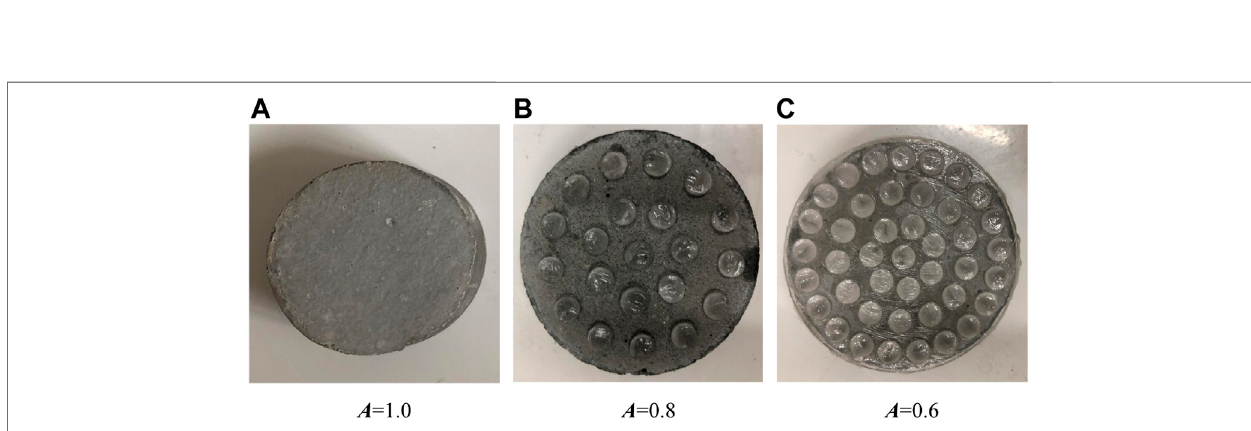
Frontiers in Earth Science |